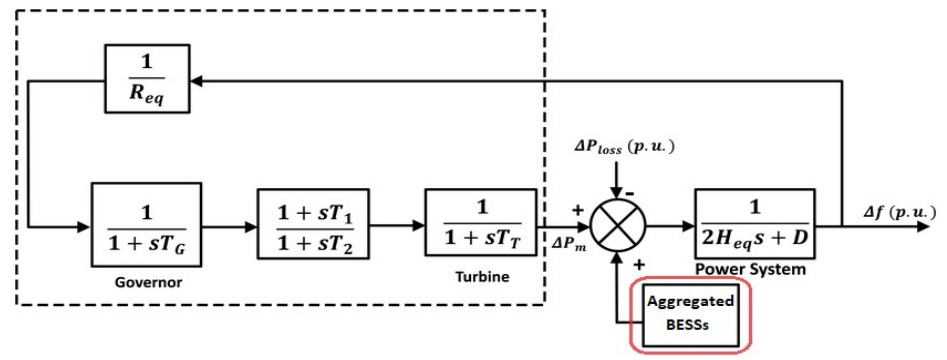
Figure 13. Schematic diagram of the test model with aggregated BESSs.